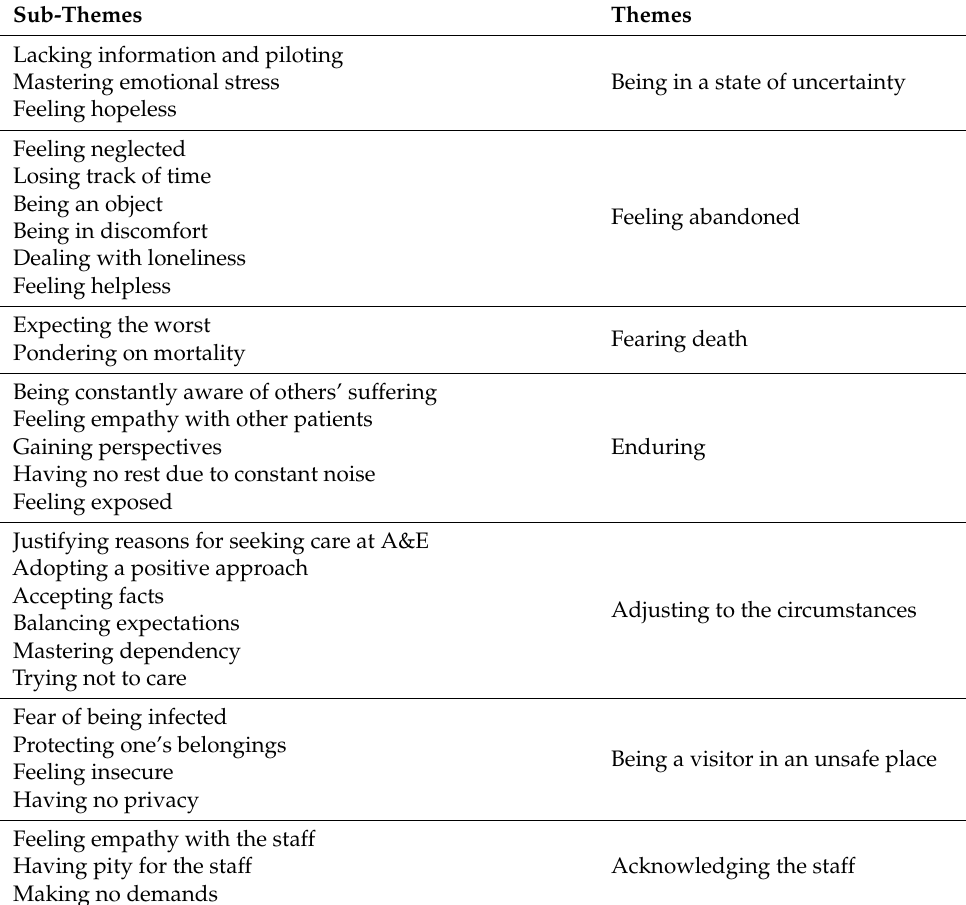
Table 3. Structural analysis of being in limbo among 17